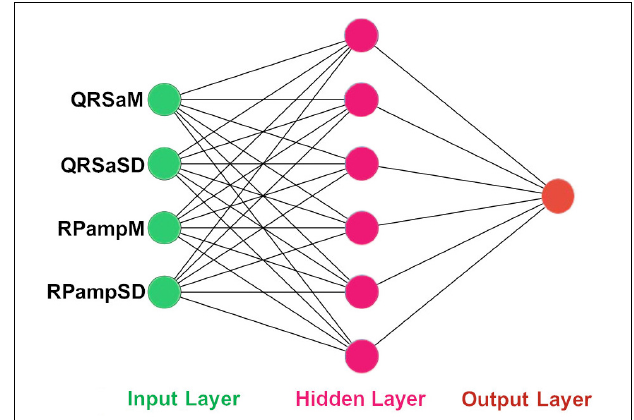
FIGURE 3 | The architecture of our ANN using 4 QRS features. The input features to the ANN. QRSaM: mean of QRS complex signed areas, QRSaSD: standard deviation of QRS complex signed areas, RPampM: mean of R-peak amplitudes, and RPampSD: standard deviation of R-peak amplitudes.